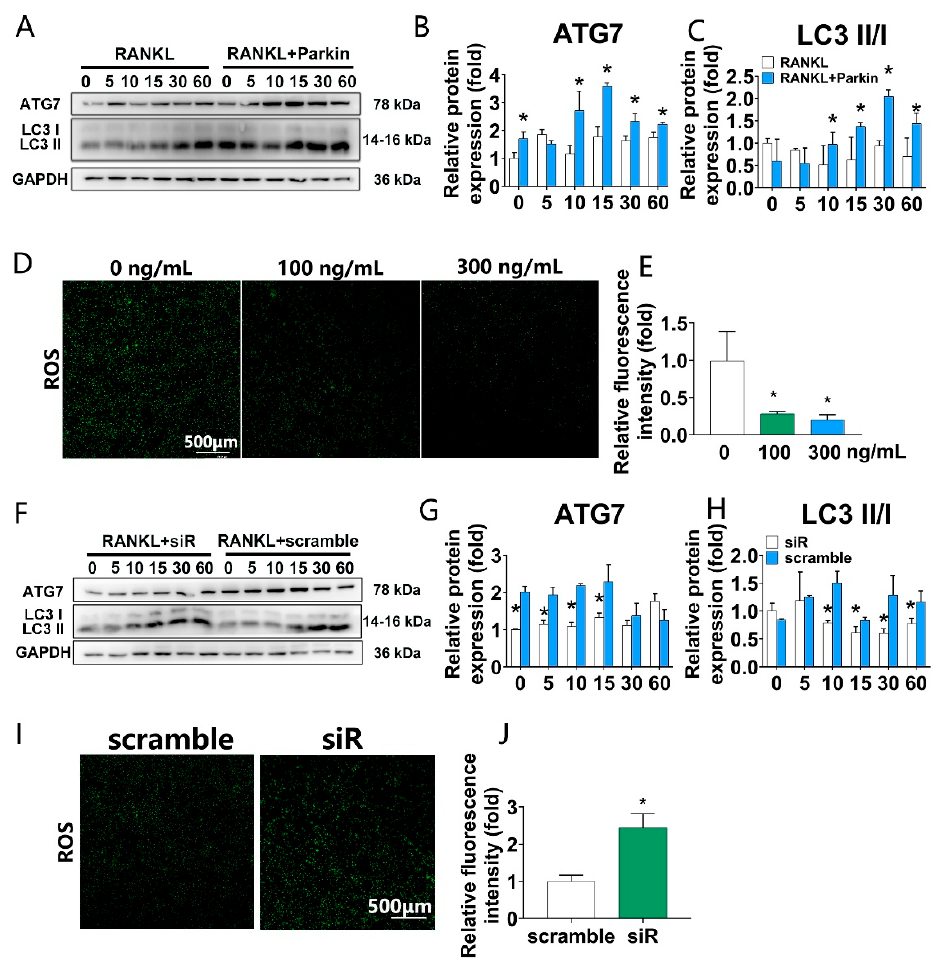
Figure 4. Parkin regulates autophagy and ROS levels during osteoclastogenesis. ( A – C ) BMMs were pre-treated with vehicle or Parkin (300 ng/mL) for 6 h and thereafter exposed to RANKL (100 ng/mL) for indicated time (0, 5, 10, 15, 30, and 60 min). Western blots showing that Parkin (300 ng/mL) significantly increased autophagy signaling (ATG7 and LC3II/I). * p < 0.05 compared with the control group (0 ng/mL Parkin). ( D , E ) BMMs were pre-treated with vehicle or Parkin (300 ng/mL) for 6 h and thereafter exposed to RANKL (100 ng/mL) for 1 day. DCFH-DA fluorescence analysis of ROS. * p < 0.05 compared with the control group (0 ng/mL Parkin). ( F – H ) BMMs were pre-treated with control siRNA(scramble) or Parkin siRNA (siRNA) for 1 day and then exposed to RANKL (100 ng/mL) for indicated time (0, 5, 10, 15, 30, and 60 min). Western blots showing that Parkin siRNA significantly decreased autophagy signaling (ATG7 and LC3II/I). ( I , J ) BMMs were pre-treated with control siRNA(scramble) or Parkin-siRNA (siRNA) for 1 day and then exposed to RANKL (100 ng/mL) for 1 day. * p < 0.05 compared with the control group